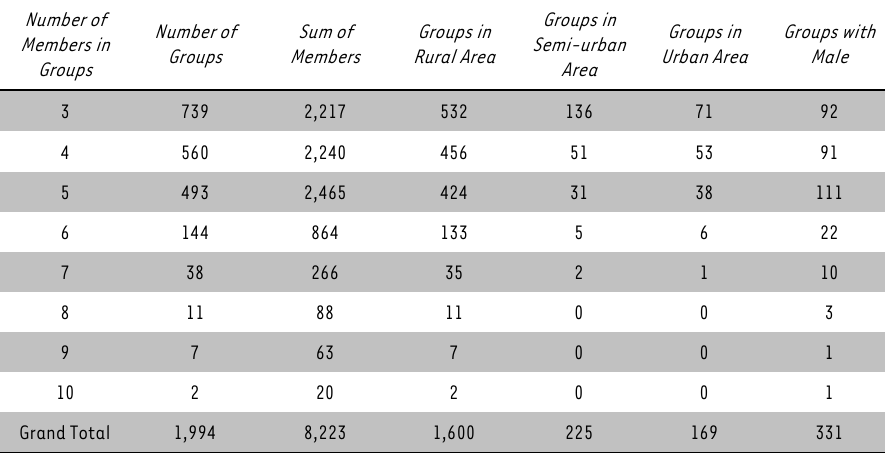
Marang Financial Services Group